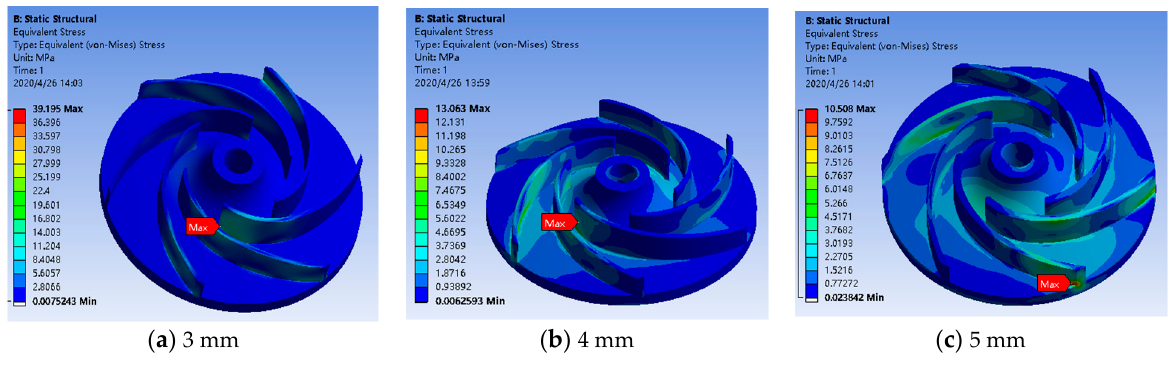
Figure 9. Stress distribution of impeller.